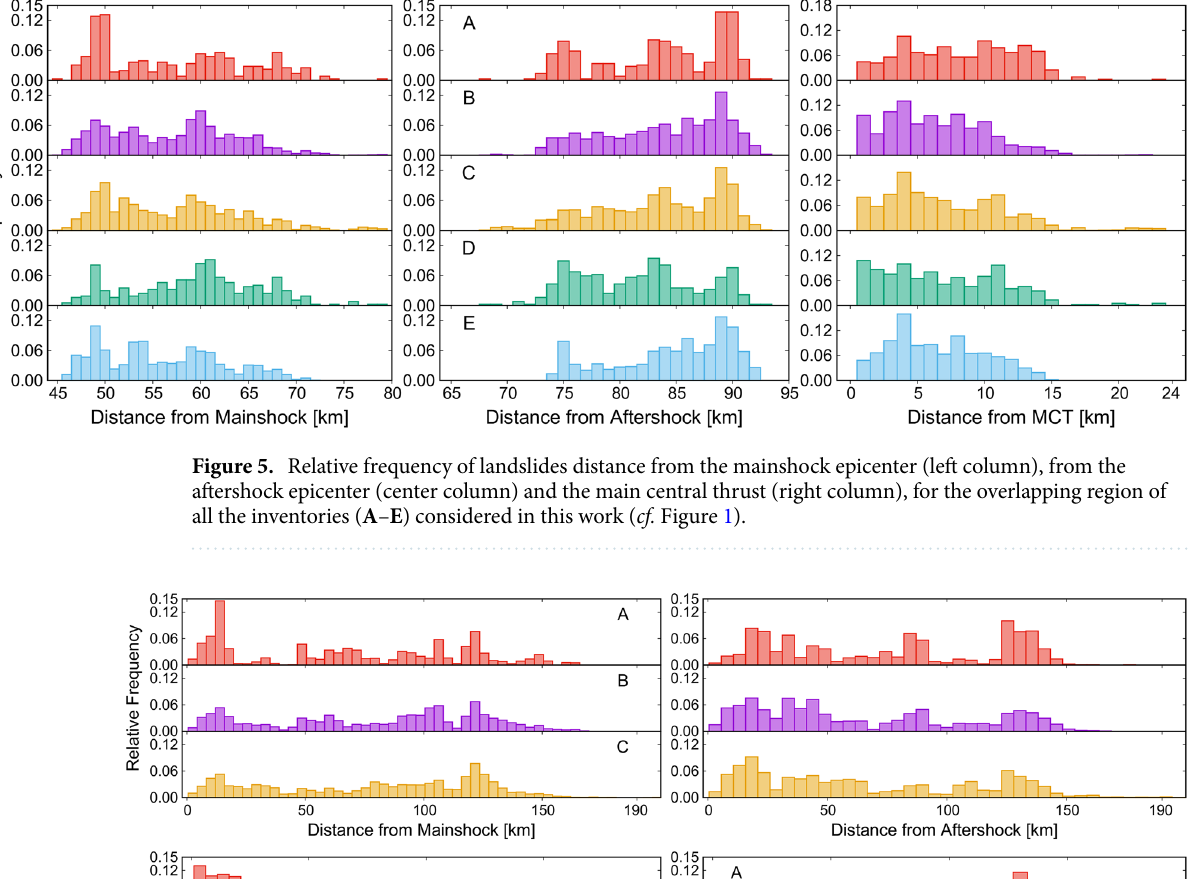
Fig. 7 help show the results of p-values associated with each inventory, stemming from the 20 runs of LR trained with different random selections of SUs. VRM (S.D) and profile curvature (S.D) were discarded following the collinearity test. The variables with p-value less than 0.5 were considered as significant factors. Slope (mean) fol- lowed by ridge landform were substantial for most of the inventories. This implies that slope is very relevant for earthquake-induced landslides 64 , as expected. The summarization of p-values of variables for each inventory is given in Supplementary Table S1. As mentioned in Step 4 ( cf . Section 3 and Fig. 2), AUC ROC values for all the inventories were plotted with three different sampling strategies (Fig. 8). The colored boxes in the figure represent the TR1 strategy (70% of the smallest number of stable or unstable SUs in each inventory as training sample and the remaining 30% in validation sample, 20 random selections). Grey boxes in Fig. 8 represents TR2 (smallest number of stable/unsta- ble SUs across all of the five inventories, and the equal number of unstable/stable for training, the remaining in validation; 20 random selections) case and the dotted line represents TR3 case (all of the SUs to train the LR;